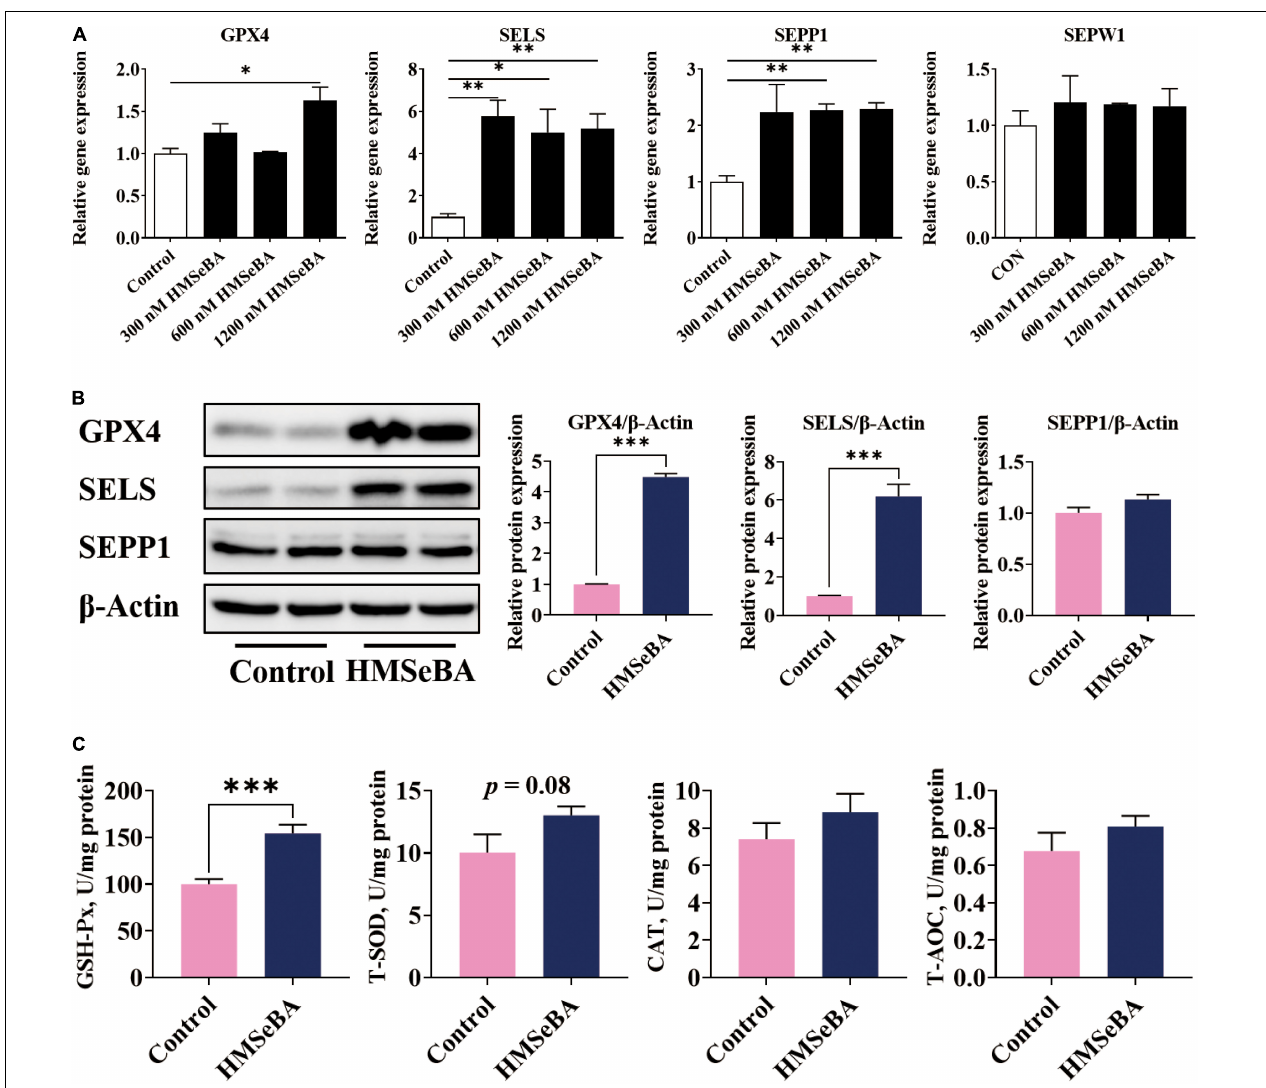
FIGURE 3 | Effect of HMSeBA supplementation on the expression of selenoproteins and the antioxidative capacity in IPEC-J2 cells. IPEC-J2 cells were treated with 1.2 µ M HMSeBA for 24 h. (A) Relative mRNA levels of selenoproteins. n = 3 for each group. (B) Relative protein abundance of GPX4, SELENOS and SELENOP. n = 4 for each group. (C) The activity of antioxidant related enzymes. n = 6 for each group. GSH-Px, glutathione peroxidase; T-SOD, total superoxide dismutase; CAT, catalase; T-AOC, total antioxidant capacity. Data are expressed as mean ± SE. ∗ P < 0.05, ∗∗ P < 0.01, ∗∗∗ P <